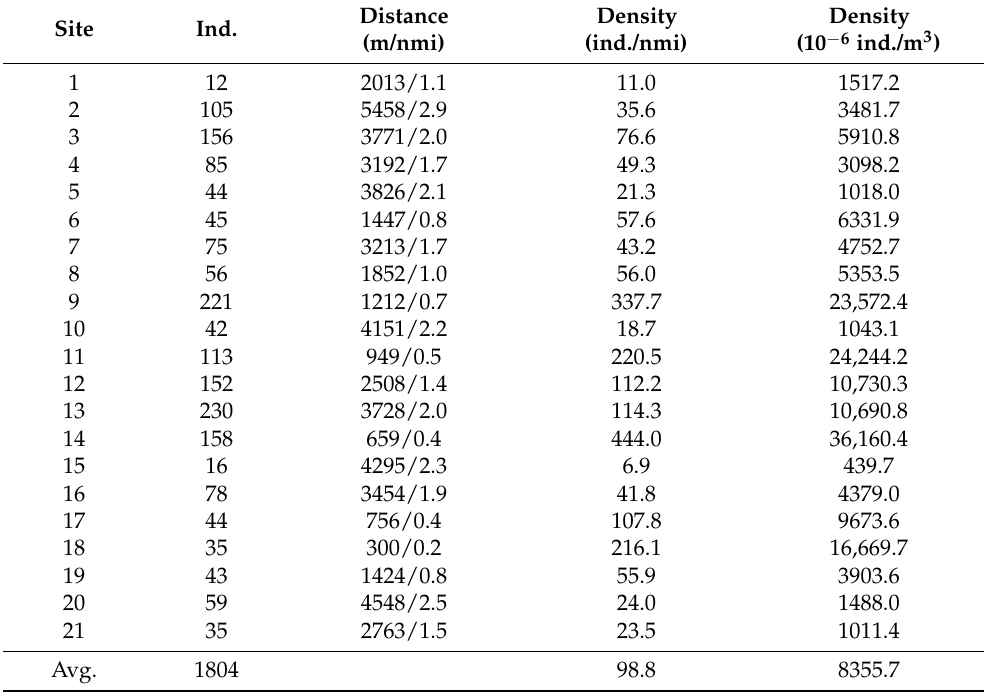
Table 2. Distribution density of jellyfish using the echo counting method in the East China Sea.